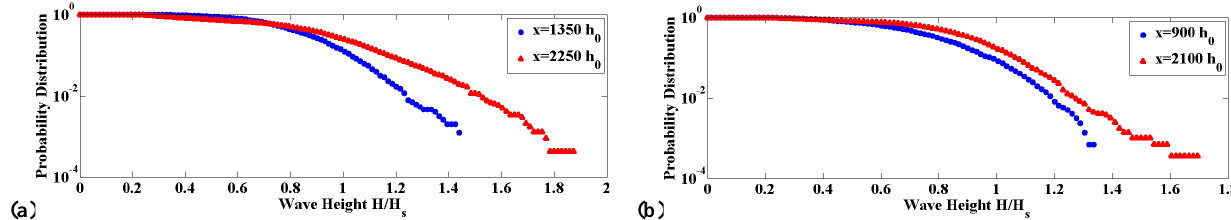
Figure 4. Exceedance probability distribution function of wave heights scaled by H s for water depth h = 10m (blue circles) and h = 5m (red triangles) for two cases of initial wave steepness: ε = 1 × 10 − 2 (a) and ε = 5 × 10 − 3 (b) .